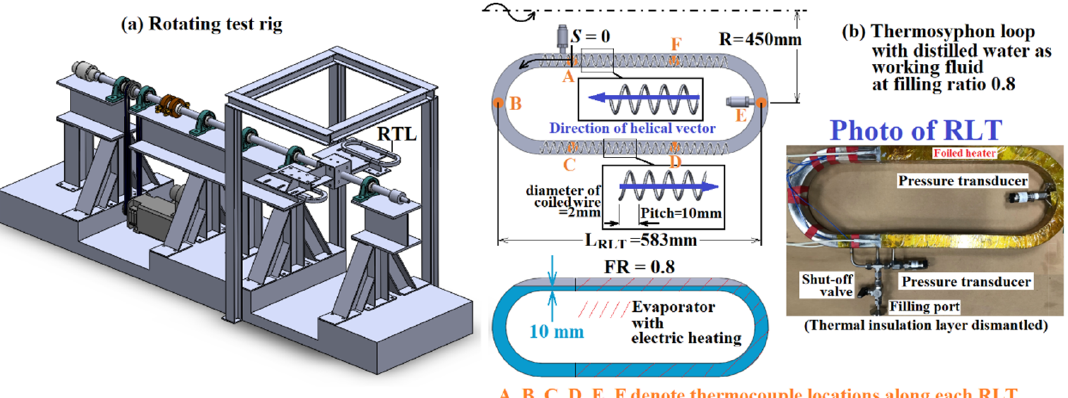
Figure 2. ( a ) rotating test rig ( b ) RTL for measuring the effective thermal conductivity and the external Nusselt number of the 180° condenser bend of the RTL using the steady-state thermocouple method [39].